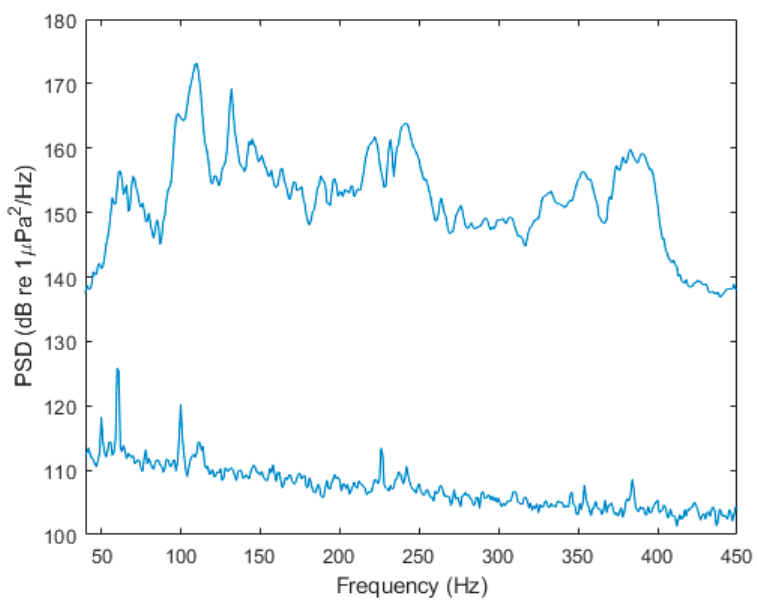
Figure 2. Power spectral density of the 50 to 400 Hz sweep as received by the hydrophone on top with below the background noise level recorded just before exposure.